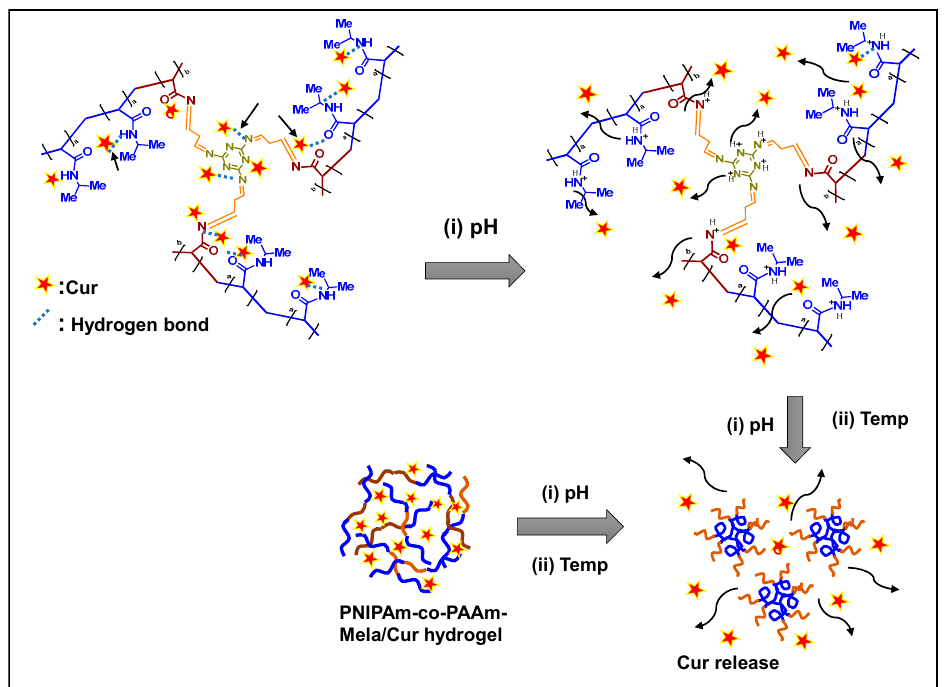
Scheme 2. A proposed schematic representation of drug loading into the